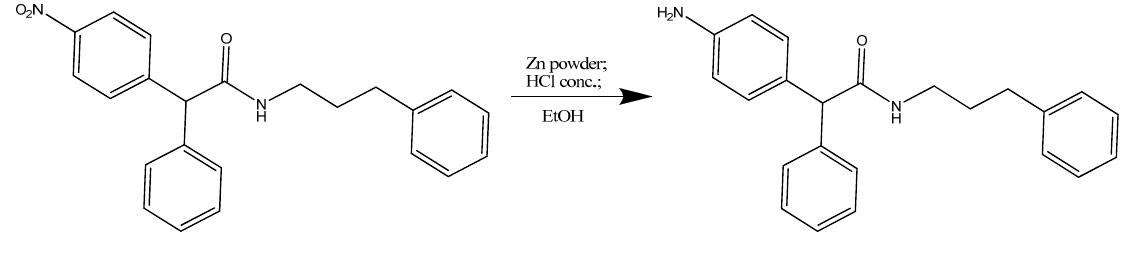
Scheme 4. Synthesis of compounds 40000 - 4 and 6